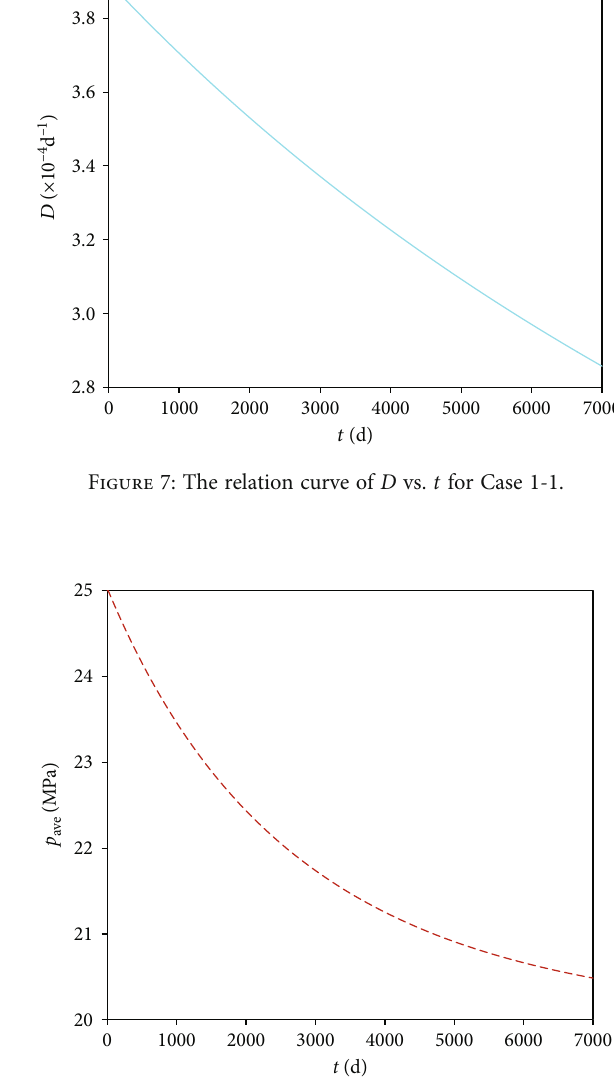
Figure 8: The estimated pro fi le of average reservoir pressure ( p for Case 1-1.